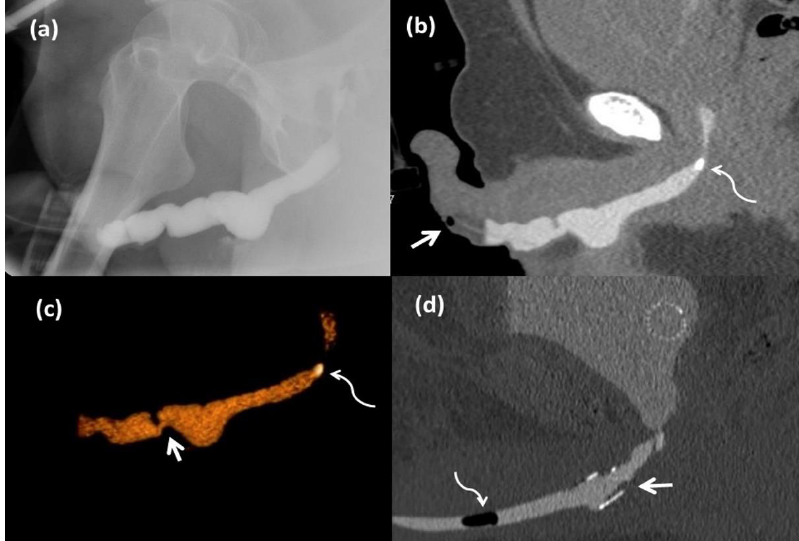
Figure 2. Urethral anomalies detected only by CT-retrograde urethrography: ( a ) retrograde urethrography (RUG) of patient with hypospadias and tortuous urethroplasty in the penile urethra, but no evident stenosis; ( b ) CT-RUG of the same patient showing bubble in hypospadic orifice (arrow), focal stenosis in urethroplasty and urethral lithiasis in bulbar cone (curved arrow); ( c ) 3D CT-RUG image of the same patient, showing focal stenosis in the urethroplasty (arrow) and urethral lithiasis (curved arrow), not visualized on RUG; ( d ) CT-RUG of the patient with bulbar urethral stent showing intraurethral bubble due to purging error (curved arrow) and discrete intra-stent spongiofibrosis (arrow) not visualized on RUG.